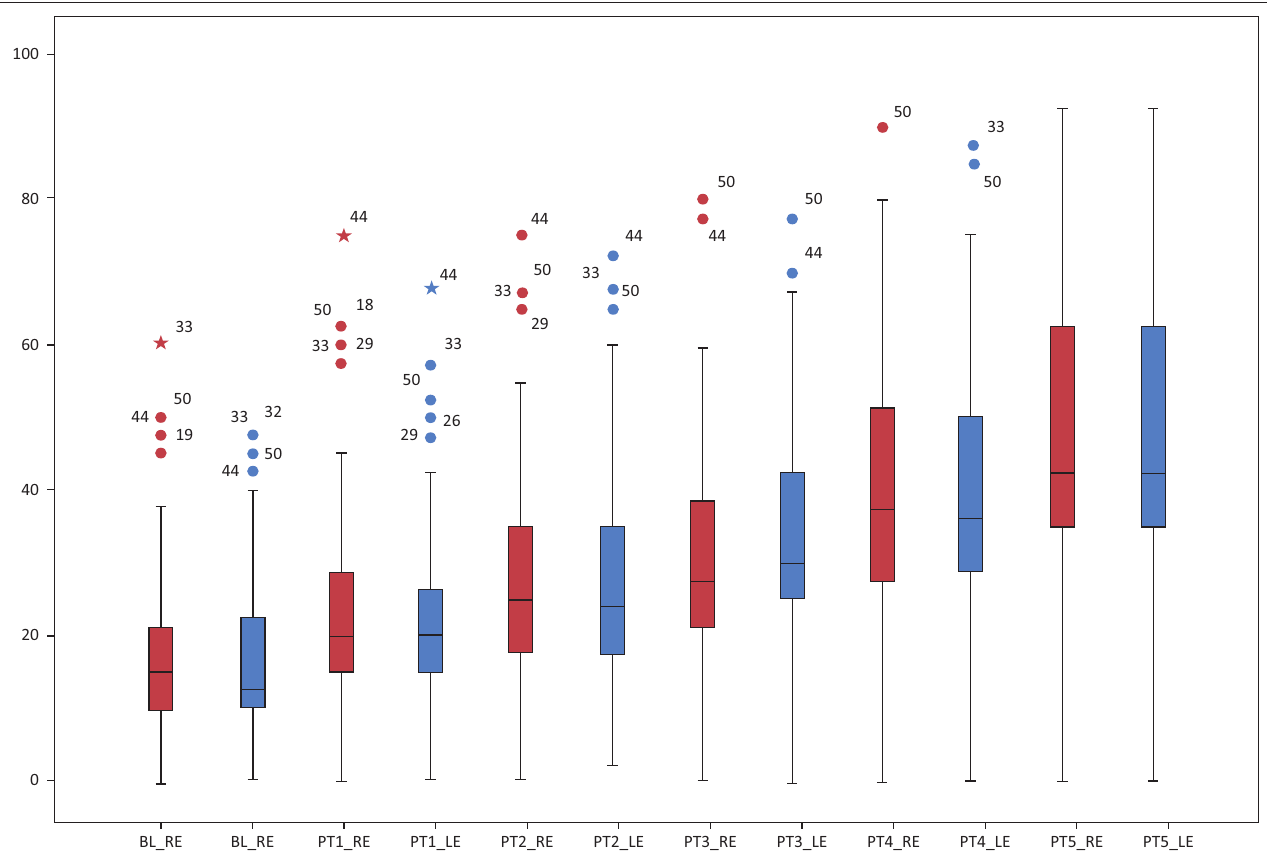
FIGURE 5: Mid-frequency threshold changes over treatment